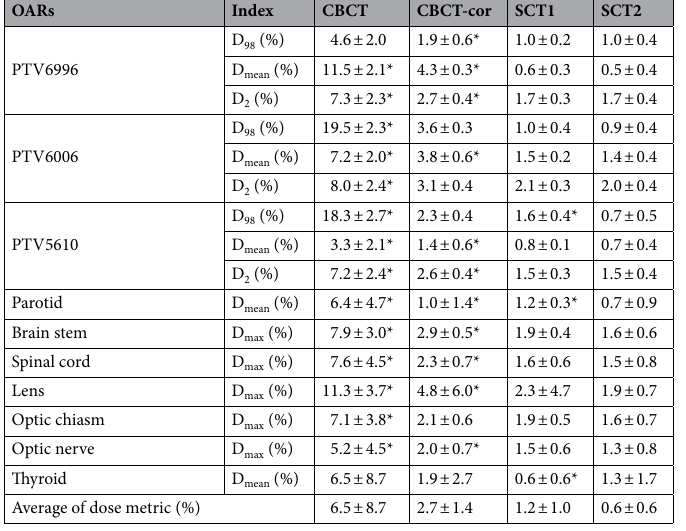
Table 2. The average relative dosimetric difference for the CBCT, CBCT_cor, SCT1 and SCT2 compared to RCT of all validation patients (mean ± SD). PTV6996, PTV6006 and PTV5610 represent the planning targets with prescription of 69.96 Gy, 60.06 Gy and 56.1 Gy, respectively. D 98 : the dose corresponding to 98% of volume. D mean : the mean dose. D 2 : the dose corresponding to 2% of volume. D max : the max dose. Significant differences ( p ≤ 0.05) are displayed using the symbol*.